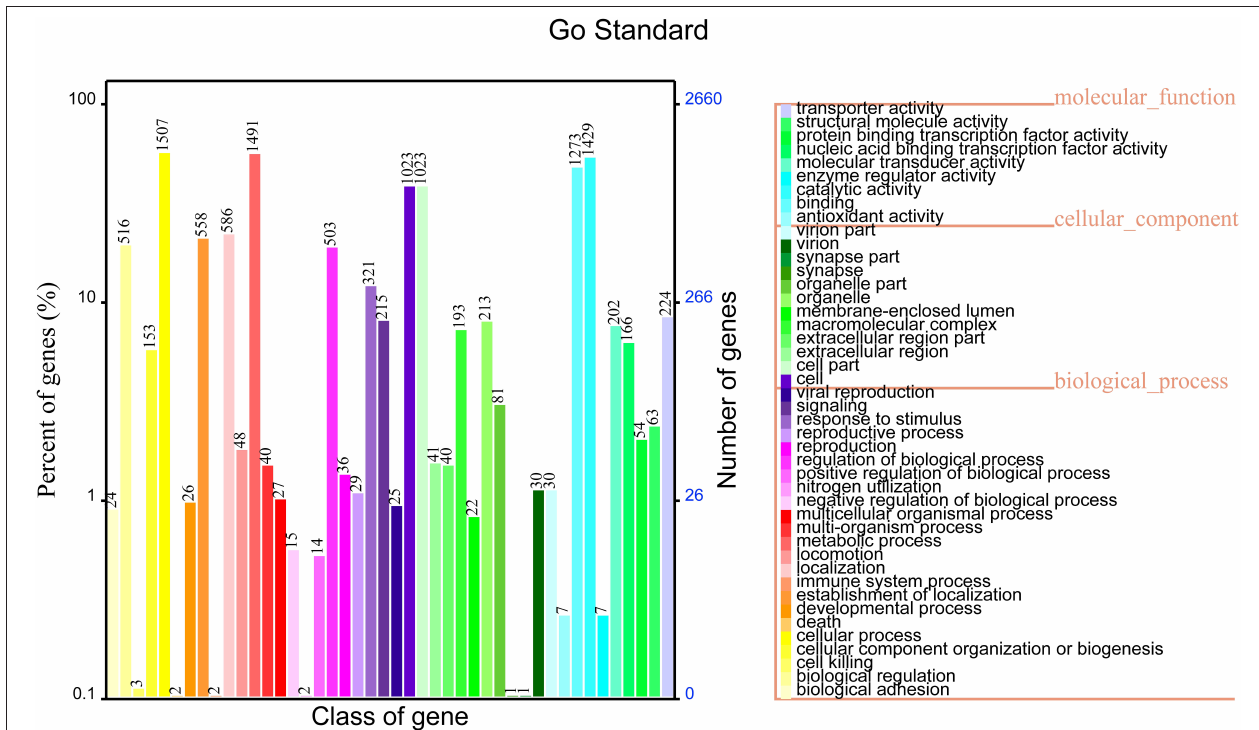
FIGURE 3 | Gene Oncology (GO) functional annotation in the whole genome of non-O1/O139 V. cholerae strain GXFL1-4.